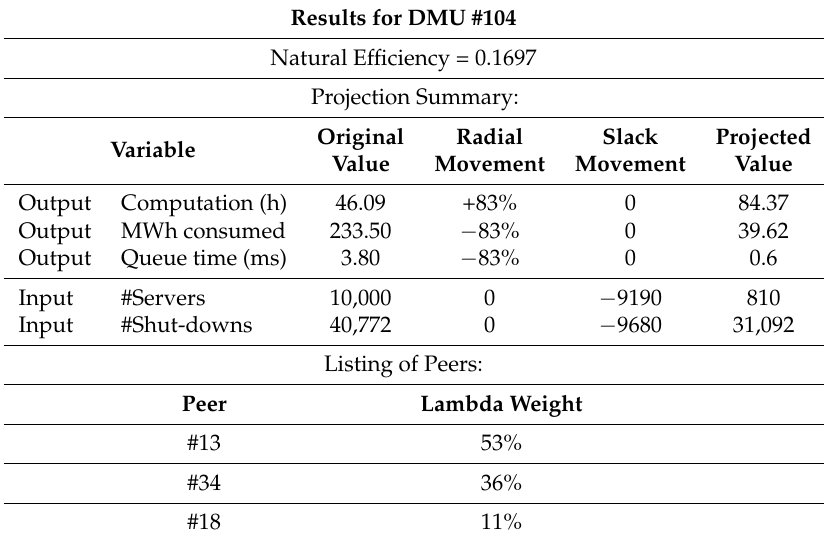
Table 6. Corrections proposed for DMU